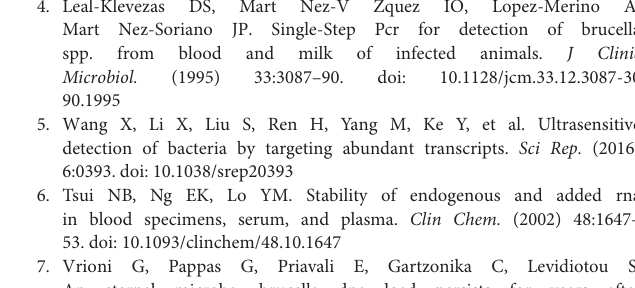
Supplementary Table 3 | Copy distribution of BMEI1001 among different species. Supplementary Table 4 | Copy distribution of BMEI0775 among different species. Supplementary Table 5 | Copy distribution of BMEI0027 among different